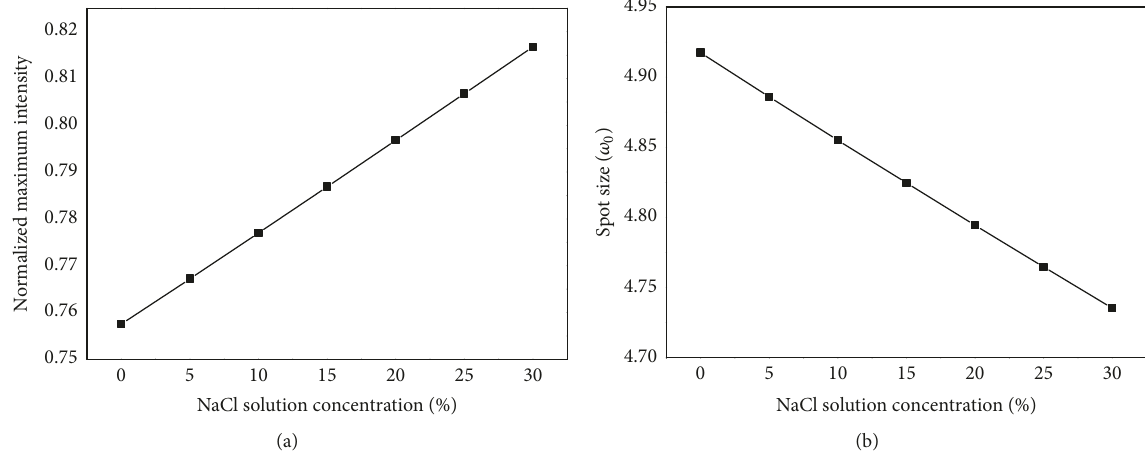
Figure 9: Relation between optical parameters of GB and NaCl solution concentration, 𝜔 0 =0.1 × 10 −3 m, 𝑛 𝑟 =1.55, 𝜔 𝑝𝑒 = 𝜔 𝑝𝑚 = 2𝜋 ] × √2.55 , 𝑍 𝐿 =2 𝑍 𝑅 = 𝑍 𝑙 =0.2m, 𝑟 =0.2m, and 𝜆 =632.8nm fixed: (a) beam intensity distribution curve; (b) beam spot size 𝑅 =4.9646cm, 𝑅 , 𝑅 ,